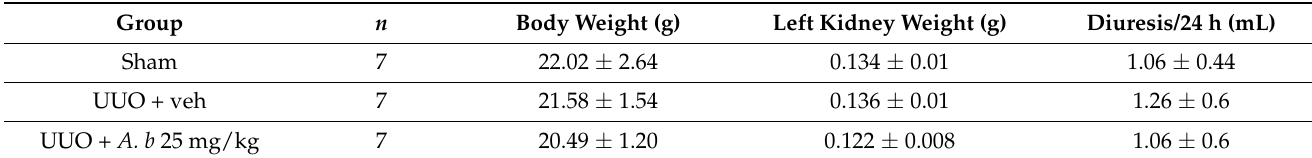
Table 2. Effect of A. borbonica ( A. b ) extract on body weight, left kidney weight and diuresis. Values are means ± SD; n = 7 animals/group.